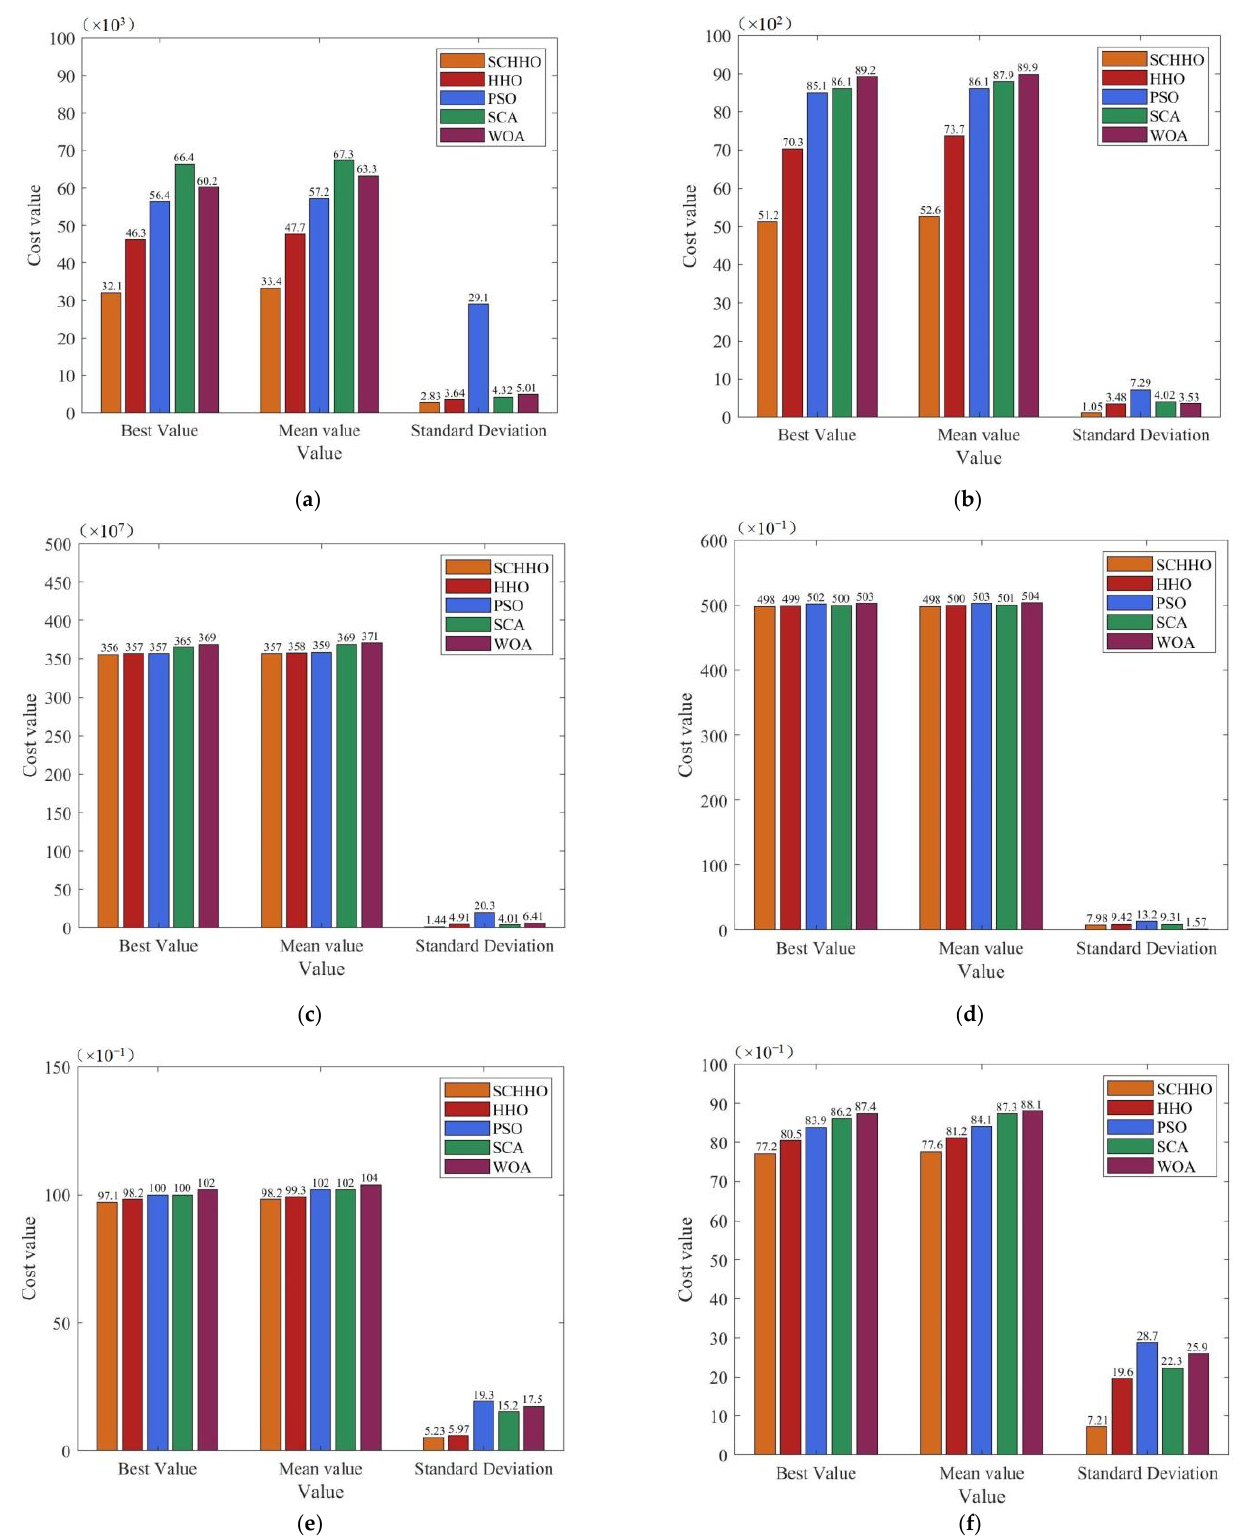
Figure 3. Experimental results on benchmark functions when n = 30. ( a ) Sphere. ( b ) Schwefel1.2.